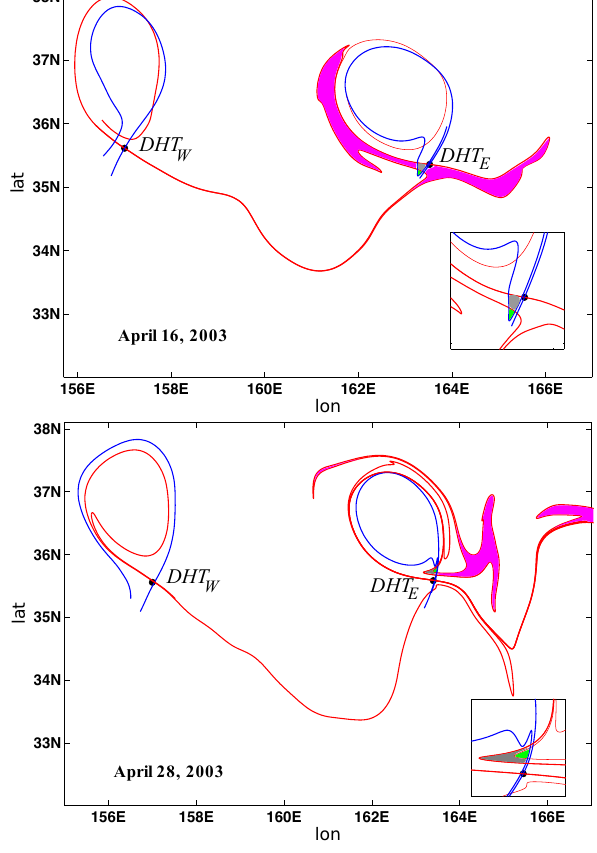
Fig. 24. Intersection of lobes governing transport across the western and eastern eddies. (a) On 16 April the grey area shows a portion of fluid ejected from the western eddy that will be entrained by the eastern eddy; (b) on 28 April the grey area has come into the eastern eddy. Figures show insets with an amplification of the entrainment